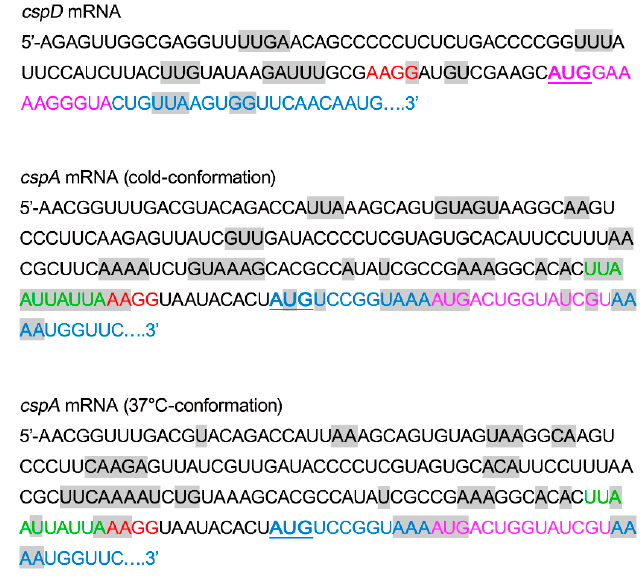
Figure 6. Accessibility of the bases of cspD and cspA mRNAs to enzymatic and chemical probing. Sequences of the proximal fragments (A 1 A 2 and D 1 D 2 ) of cspD and cspA , the latter in both its cold- and 37 °C-conformation, as indicated. The initiation triplets AUG are underlined, the SD (red), the AU-rich (green), the coding region (light blue), the DB regions (magenta) and the unpaired bases present in single stranded conformation (highlighted in grey) as deduced from enzymatic and chemical probing on cspA mRNA [19] and cspD mRNA [29] are indicated.